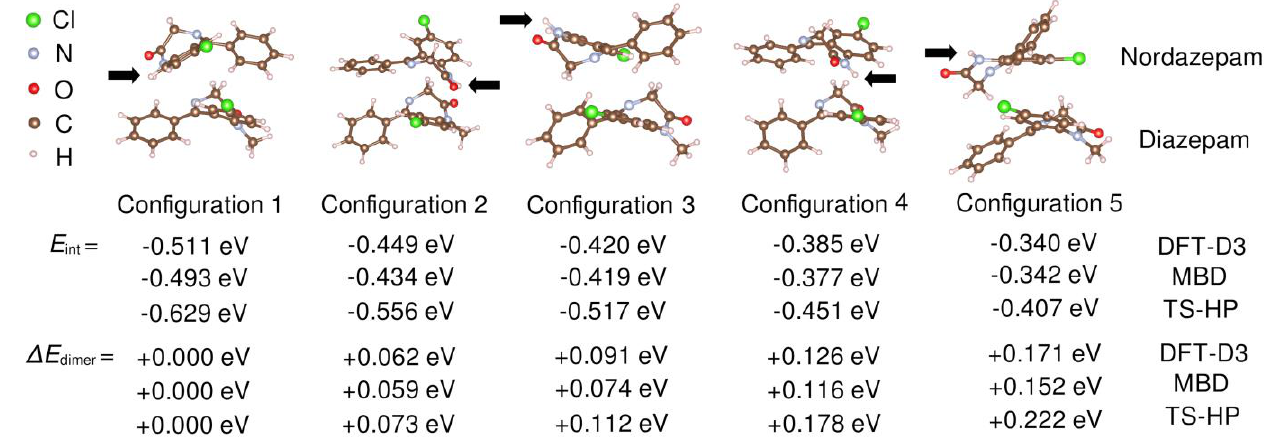
Figure 7. DFT interaction energies, E int , estimated for several heteromolecular dimer configurations. Results were obtained with three different van der Waals DFT functionals, namely DFT-D3, MBD, and TS-HP. The dimer energies are referred to as “Configuration 1”, the most stable molecular arrangement systematically found in our vdW-DFT simulations, ∆ E dimer = E Configuration x − E Configuration 1 . The positions of the Nordazepam amidic nitrogen are indicated with black arrows.